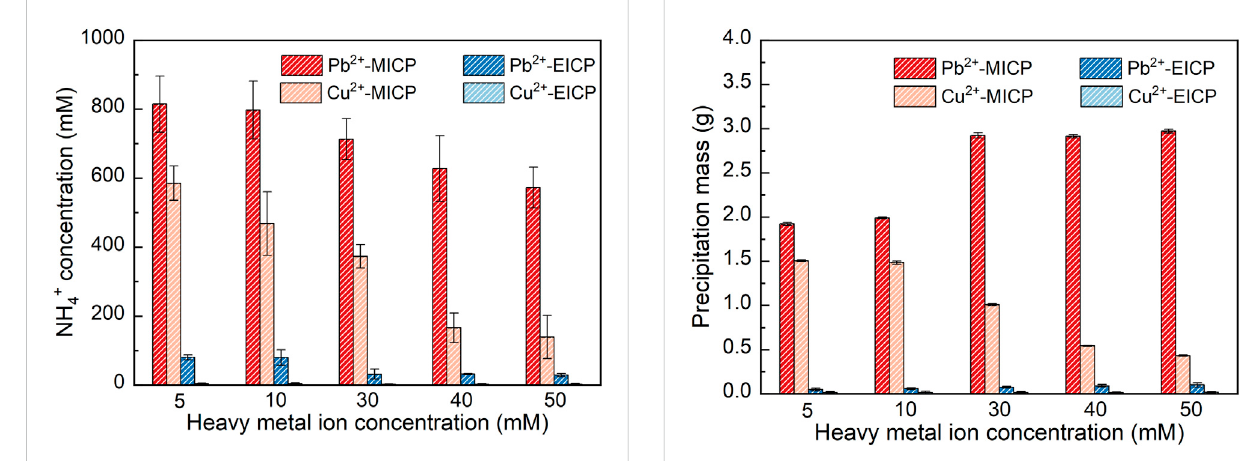
FIGURE 3 Relationships of NH 4 + concentration versus Pb 2+ or Cu 2+ concentration under MICP and EICP respectively.